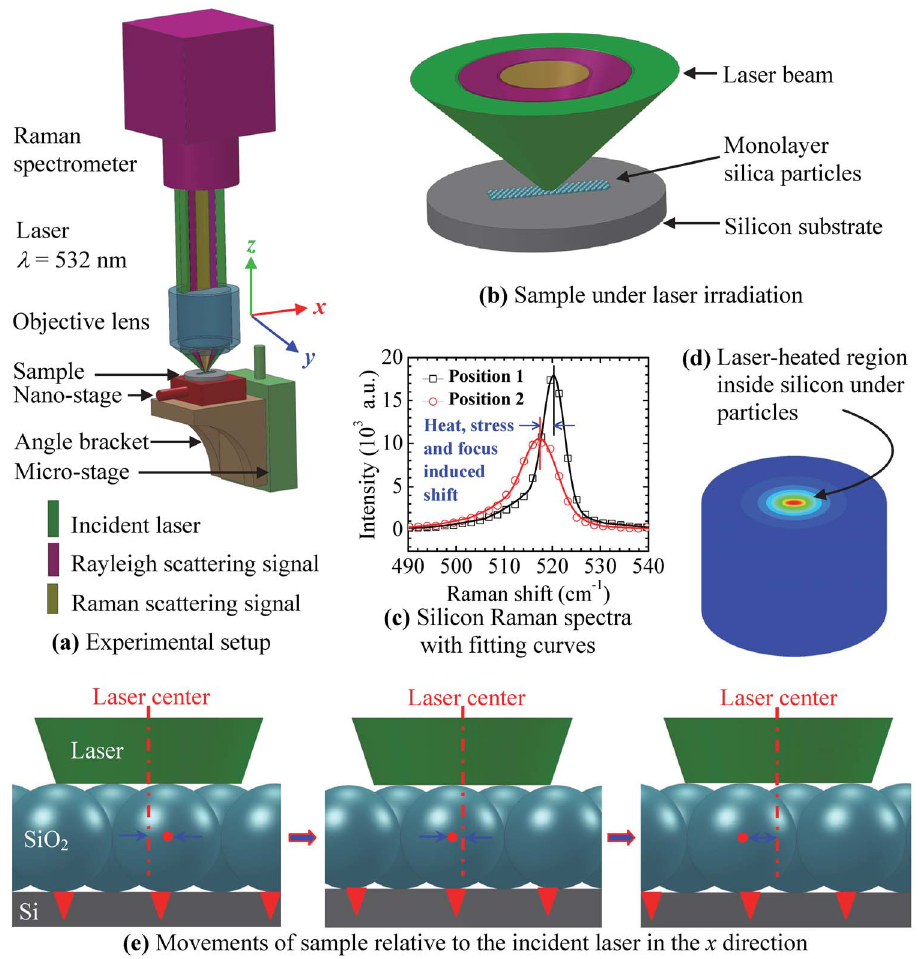
Figure 2. Schematic of experimental setup for far-field nanoscale imaging (not to scale). (a) A sample is located under an objective- focused laser beam from a Raman spectrometer. The movement of sample in the x direction is controlled by a piezo-actuated nano-stage. The focal level of the laser on the sample in the z direction is controlled by a motorized micro-stage. (b) The sample consists of a silicon substrate and a monolayer of silica particles. The spot size of the incident laser is about 0.5 m m in the x - y plane on a silicon substrate. (c) The Raman spectrum shifts to left due to the near-field laser heating, stress, and the out-of-focus effect. (d) The silicon substrate is heated in a sub-wavelength region ( r , 200 nm) right beneath the particles. (e) During the experiment, the position of the laser beam is fixed, and the sample moves along the x direction controlled by the nano-stage electrically without any touch of the sample and other equipment. The step of movement is 27 nm in a range of about 4 m m.